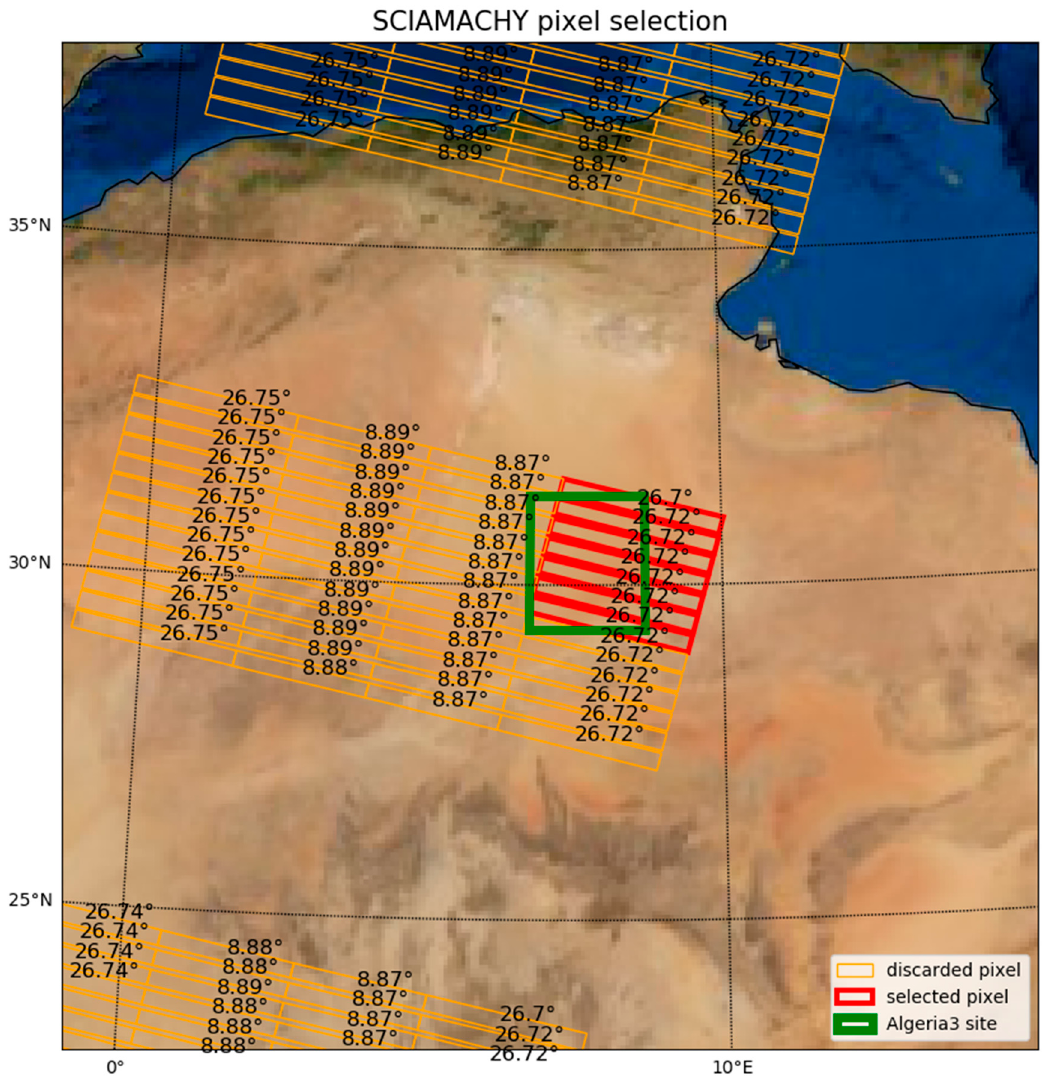
Figure 3. Scan pattern of one SCIAMACHY overpass over Algeria-3 with 4 pixel per scanline. The numbers provide the viewing zenith angle at the center of each pixel. The green box is the 2° × 2° box of the target site. The red pixel are considered for the computation of the spectral band adjustment factor for the homogenisation of the timeseries at this target. The orange pixel are disregarded.